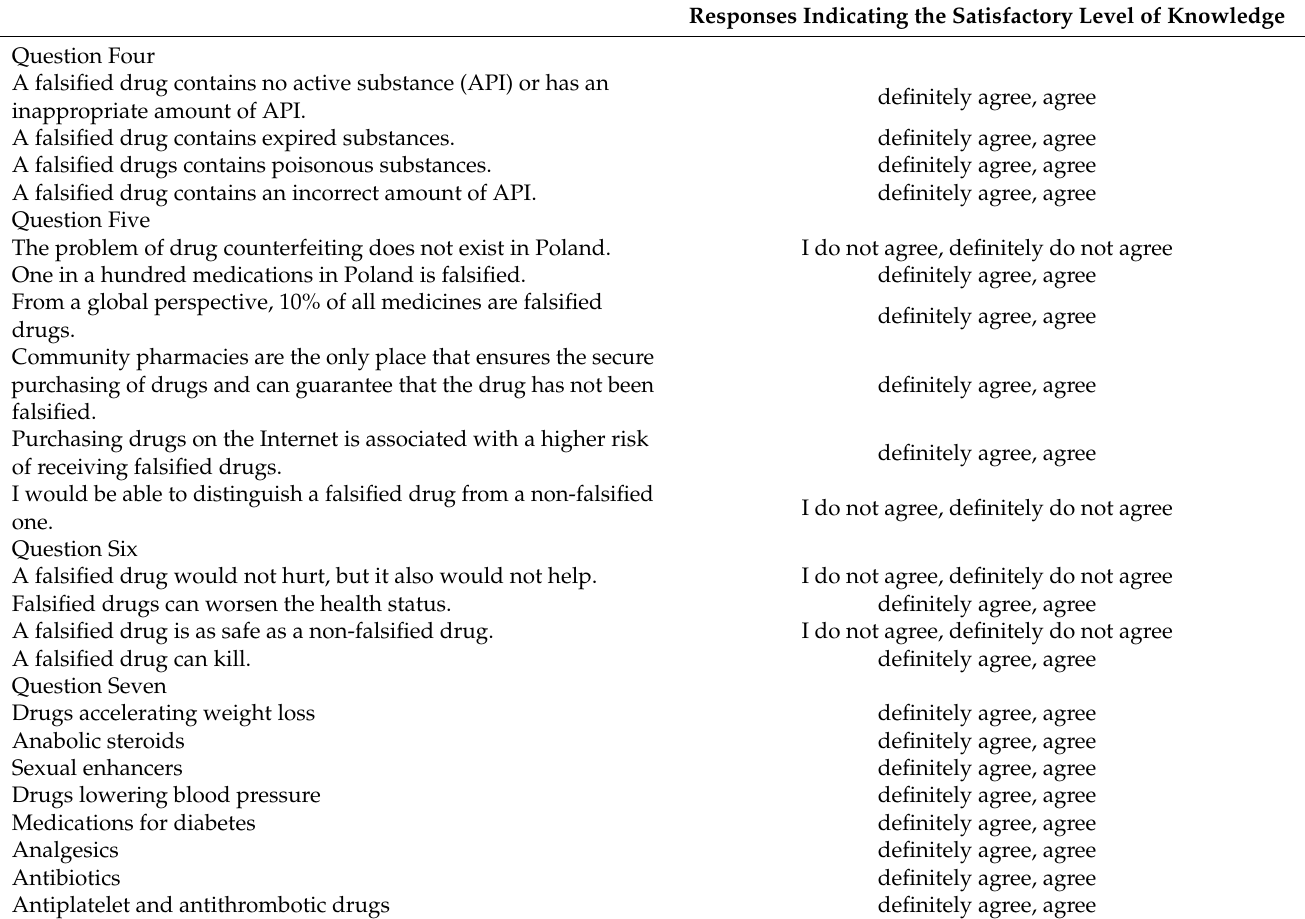
Table 1. Responses indicating a satisfactory level of